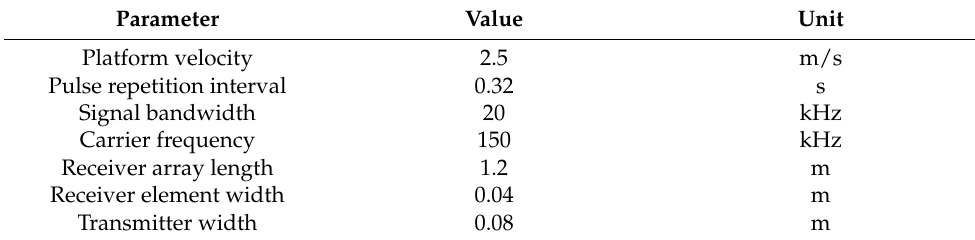
Table 7. Real SAS parameters with a narrow-bandwidth signal.